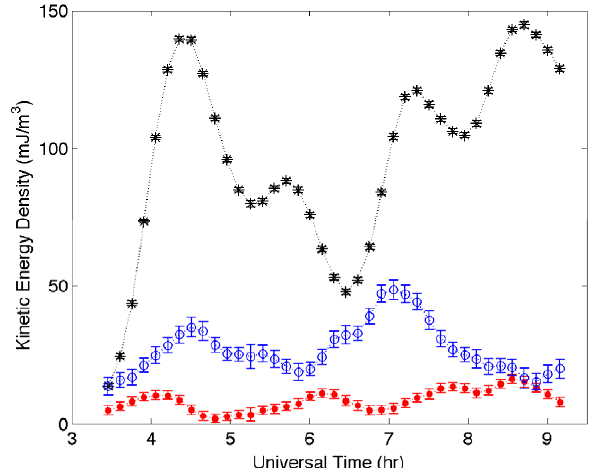
Figure 4. Kinetic energy density on August 17, 1994 in the same format as Figure 1. Potential Fig. 4. Kinetic energy density on 17 August 1994 in the same for- mat as Fig. 1. Potential energy per unit mass (J/kg) can be found energy per unit mass (J/kg) can be found by multiplying the KED by: 2.3 (Low), 0.46 (Middle) by multiplying the KED by: 2.3 (Low), 0.46 (Middle) and 0.052 (High). and 0.052 (High).